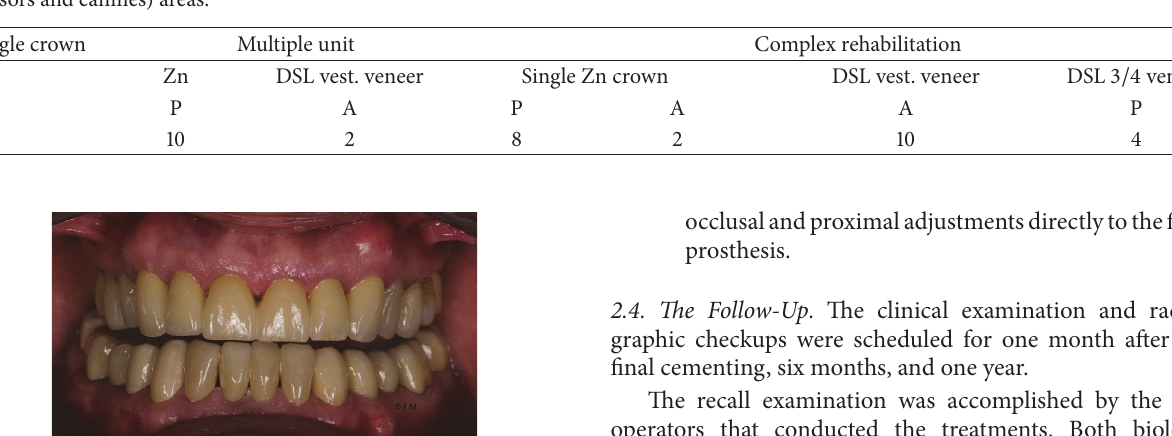
Table 1: Number of single zirconia crowns (Zn); multiple unit prosthetic rehabilitation with zirconia crown (Zn) and lithium disilicate vestibular veneer (DSL vest. veneer); complex rehabilitation with single zirconia crown (Zn), lithium disilicate vestibular veneer and lithium disilicate vestibular veneer with palatal extension (DSL 3/4 veneer) and their distribution in posterior (P: premolars, molars) and anterior (A: incisors and canines) areas.